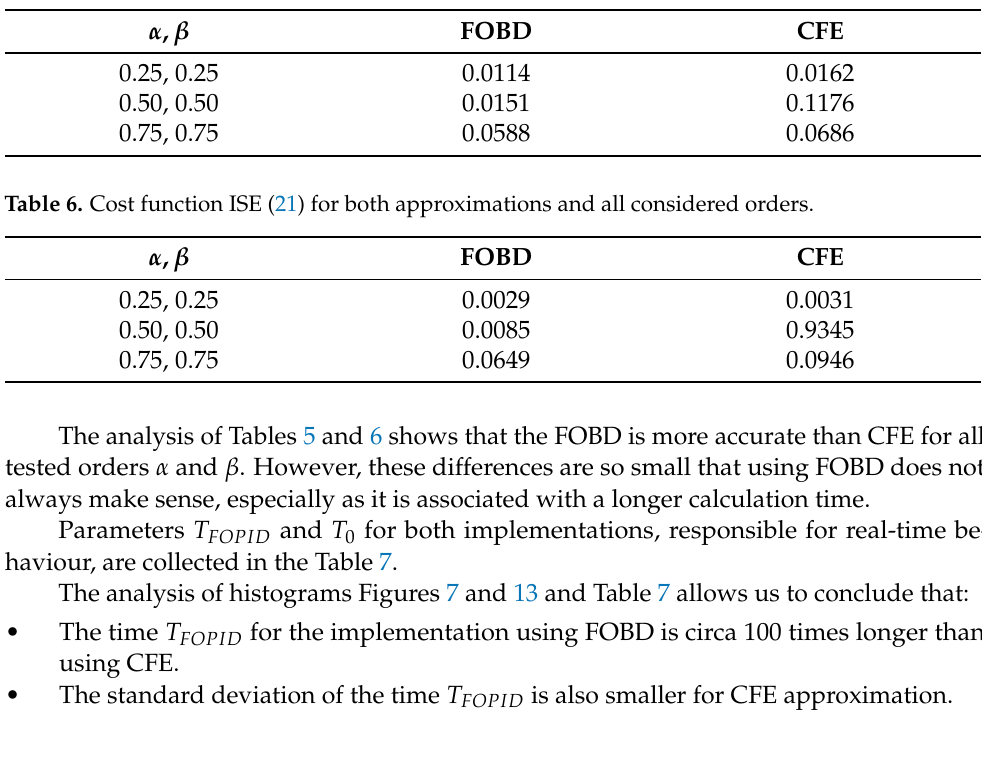
Table 5. Cost function IAE (20) for both approximations and all considered orders.